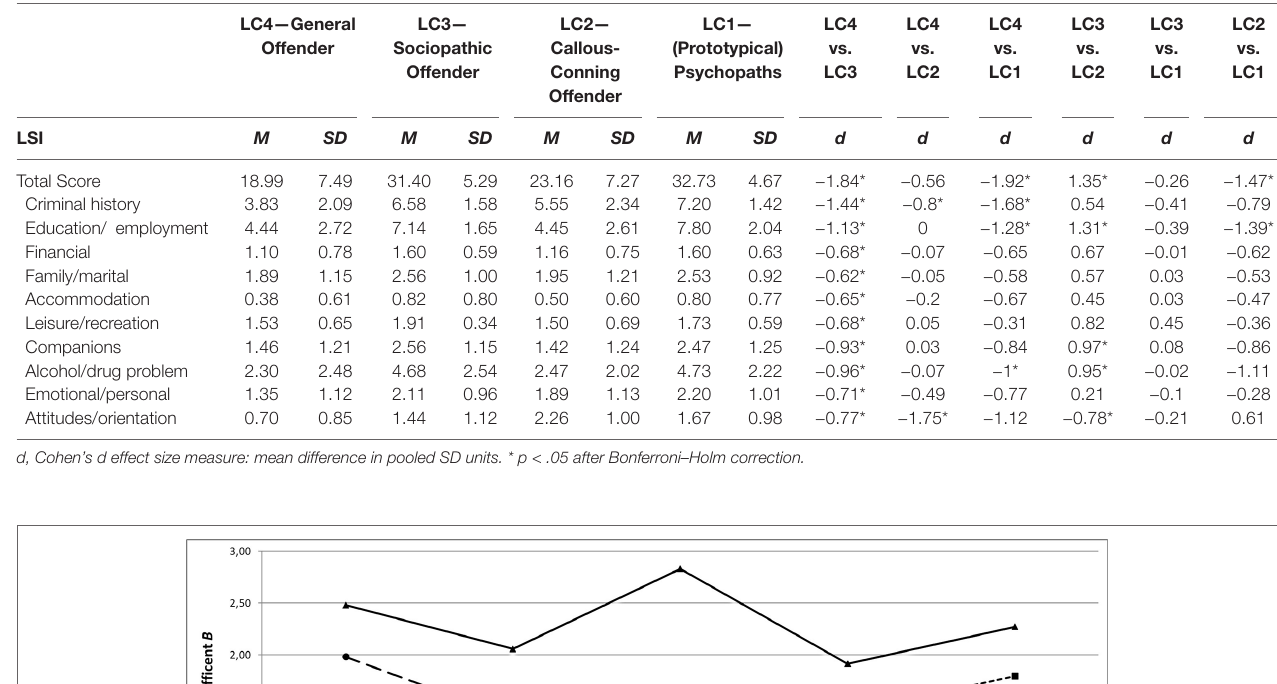
TABLE 2 | Mean (SD) Scores of the Latent Classes and Pairwise Comparisons Between Classes for Each LSI Subcomponent.